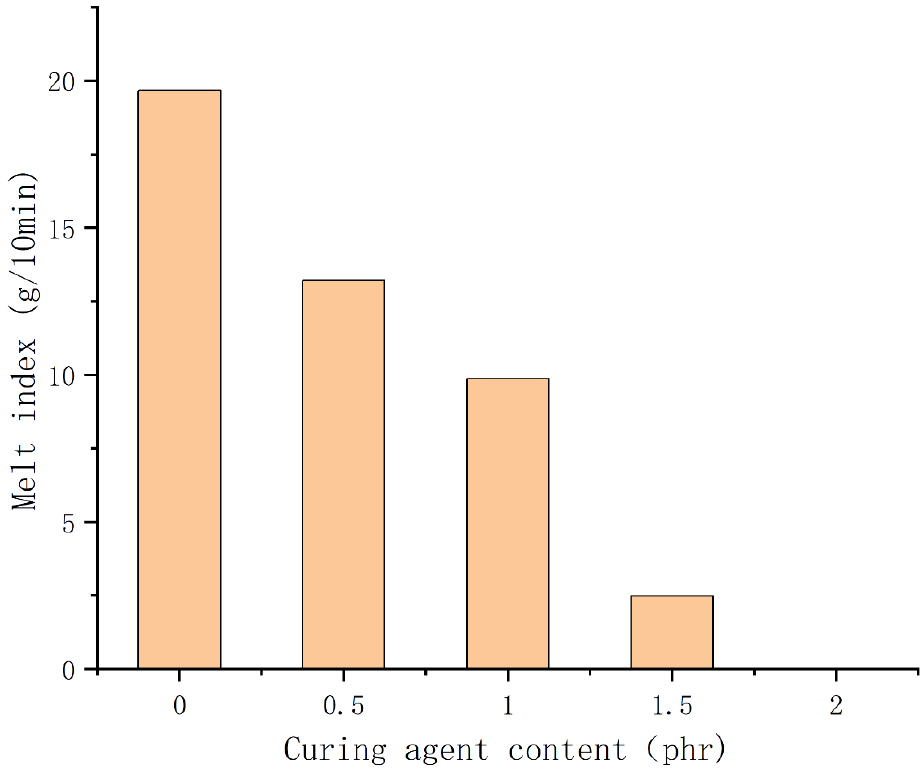
Figure 13. Histogram of the melt index of samples 1–5.